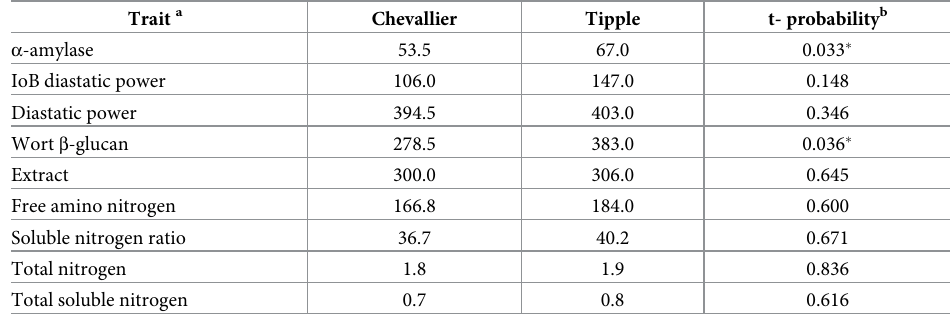
Table 4. The mean values associated with malting traits for Chevallier and